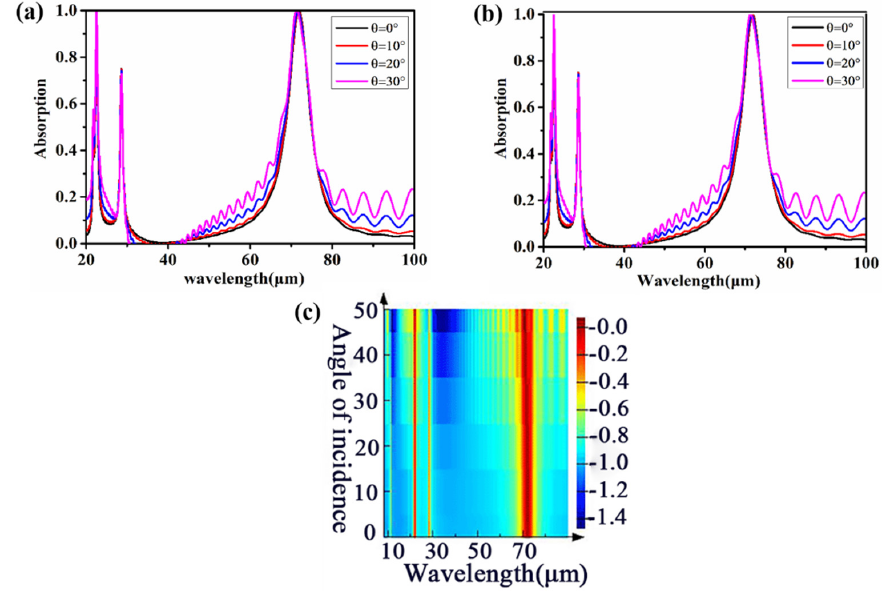
Figure 8. ( a ) The generated spectra at different incident angles of light under TM polarization. ( b ) The generated spectra at different incident angles of light under TE polarization. ( c ) Scanning graph of the absorbance of the two peaks at different polarization azimuths.